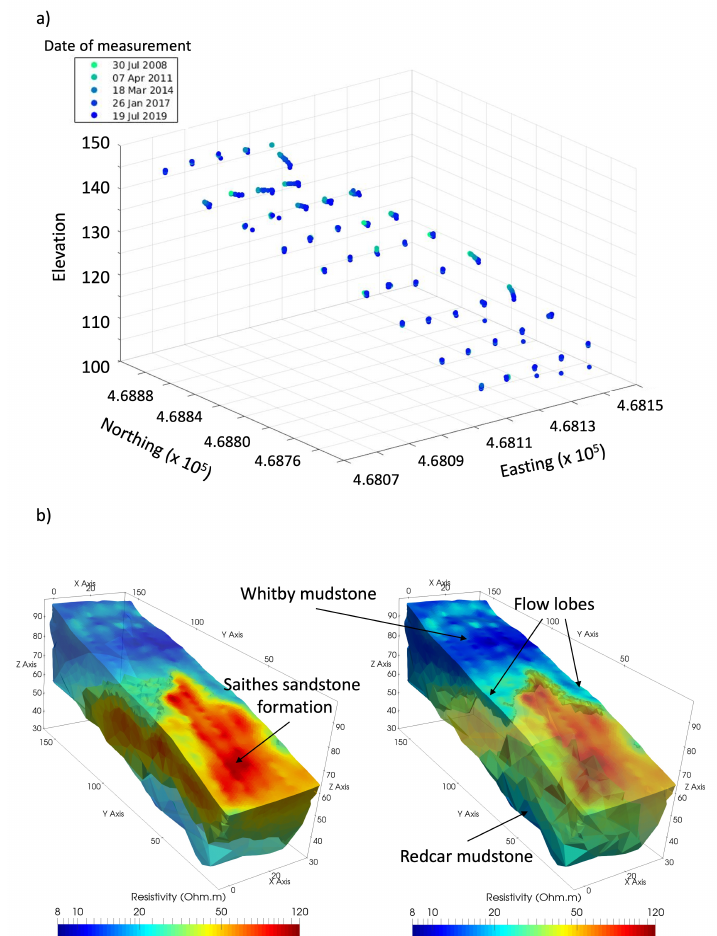
Figure 3. ( a ) Three-dimensional motion of the pegs that are used for the ERT measurements. Fifty- seven surveys were carried out between 30 July 2008 and 19 July 2019. The movement of the pegs is represented with shades of blue: initial positions with lighter and final position with darker blue. ( b ) Results of a typical ERT survey (after Boyd et al., 2019). The higher resistivity block is the Staithes Sandstone Formation, while the lower resistivity blocks on the bottom and the top are the Redcar Mudstone and Whitby Mudstone formations, respectively. The moving flow lobes are visible on the